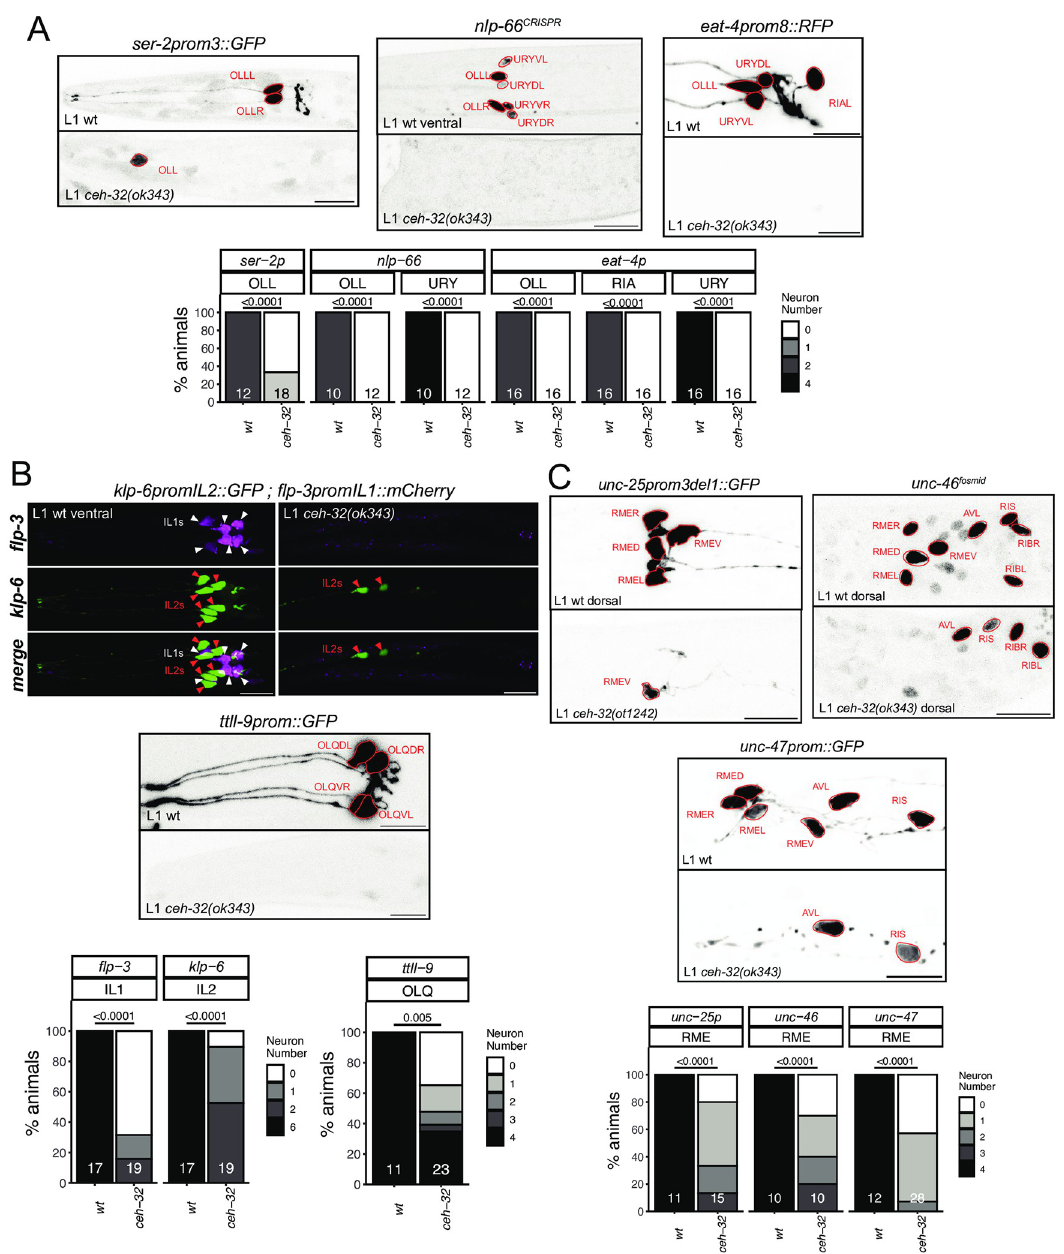
Fig 6. The SIX3/6 ortholog ceh-32 controls the identity of neurons in the anterior ganglion. Fig 6A: In ceh-32(ok343) null mutant animals, OLL, URY but also RIA markers are almost always lost ( ser-2prom3 otIs138 , nlp-66(syb4403) , eat-4prom8 otIs521) . Fig 6B: ceh-32 also controls IL1 identity ( flp-3 / otIs703 marked with white triangles), and affects neurons where it is not expressed in adults (IL2: klp-6 myIs13 marked with red triangles; OLQ: ttll-9 otIs849 ). Representative images of wild type and mutant worms are shown with 10 μ m scale bars. Graphs compare expression in wild type and mutant worms with the number of animals examined listed at the bottom of the bar. P-values were calculated by Fisher’s exact test. Fig 6C: In ceh-32(ok343) and ceh-32(ot1242) null mutant animals, the GABAergic identity of all RME classes is affected ( unc-25prom3del1 otIs837 , unc-47 oxIs12 , unc-46 fosmid otIs568 ). ceh-32 is expressed in adults in both RME and RIB, but ceh-32 loss did not affect RIB identity ( unc-46 otIs568 ). Representative images of wild type and mutant worms are shown with 10 μ m scale bars. Graphs compare expression in wild type and mutant worms with the number of animals examined listed at the bottom of the bar. P-values were calculated by Fisher’s exact test.